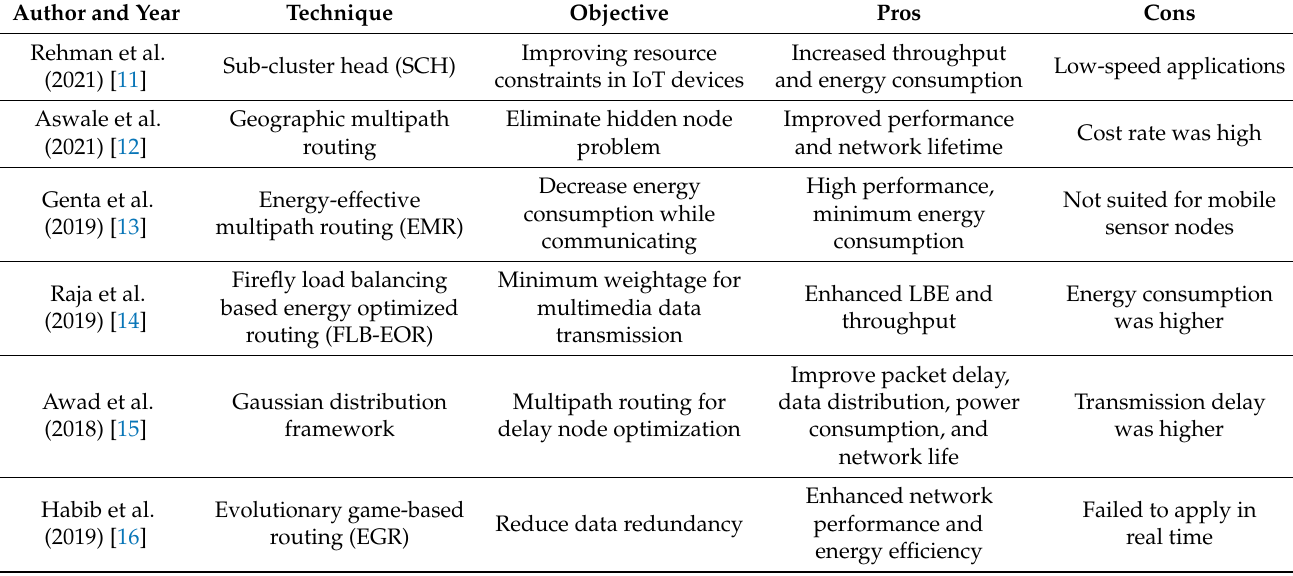
Table 1. Literary works of various